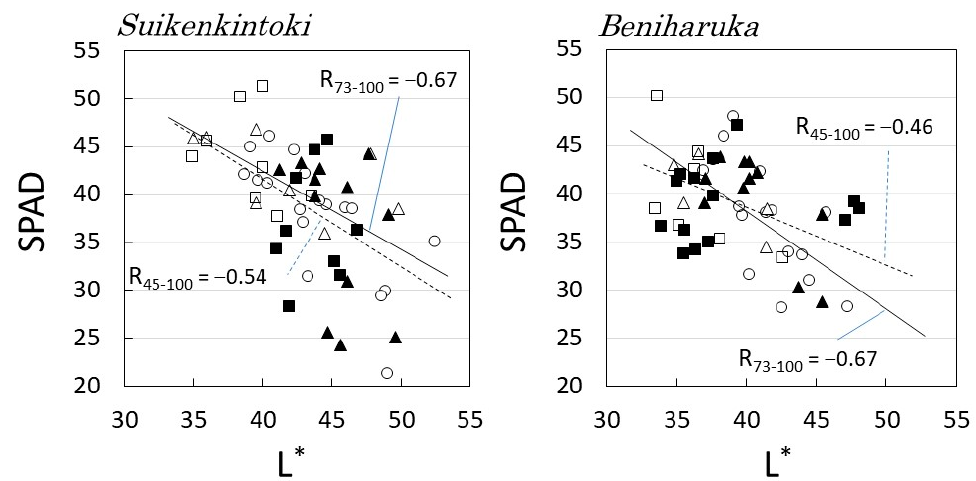
Figure 7. Relationships between leaf lightness (L*) and chlorophyll content (SPAD) in each solar radiation rate. Symbols: 〇 ; Top (SR = 100%), △ ; M out (85%), □ ; B out (73%), ▲ ; M in (69%), and ■ ; B in (45%). The approximate lines were determined by the least-squares method, and R 45-100 denotes the correlation coefficient for all data, and R 73-100 denotes the correlation coefficient for data excluding M in and B in .